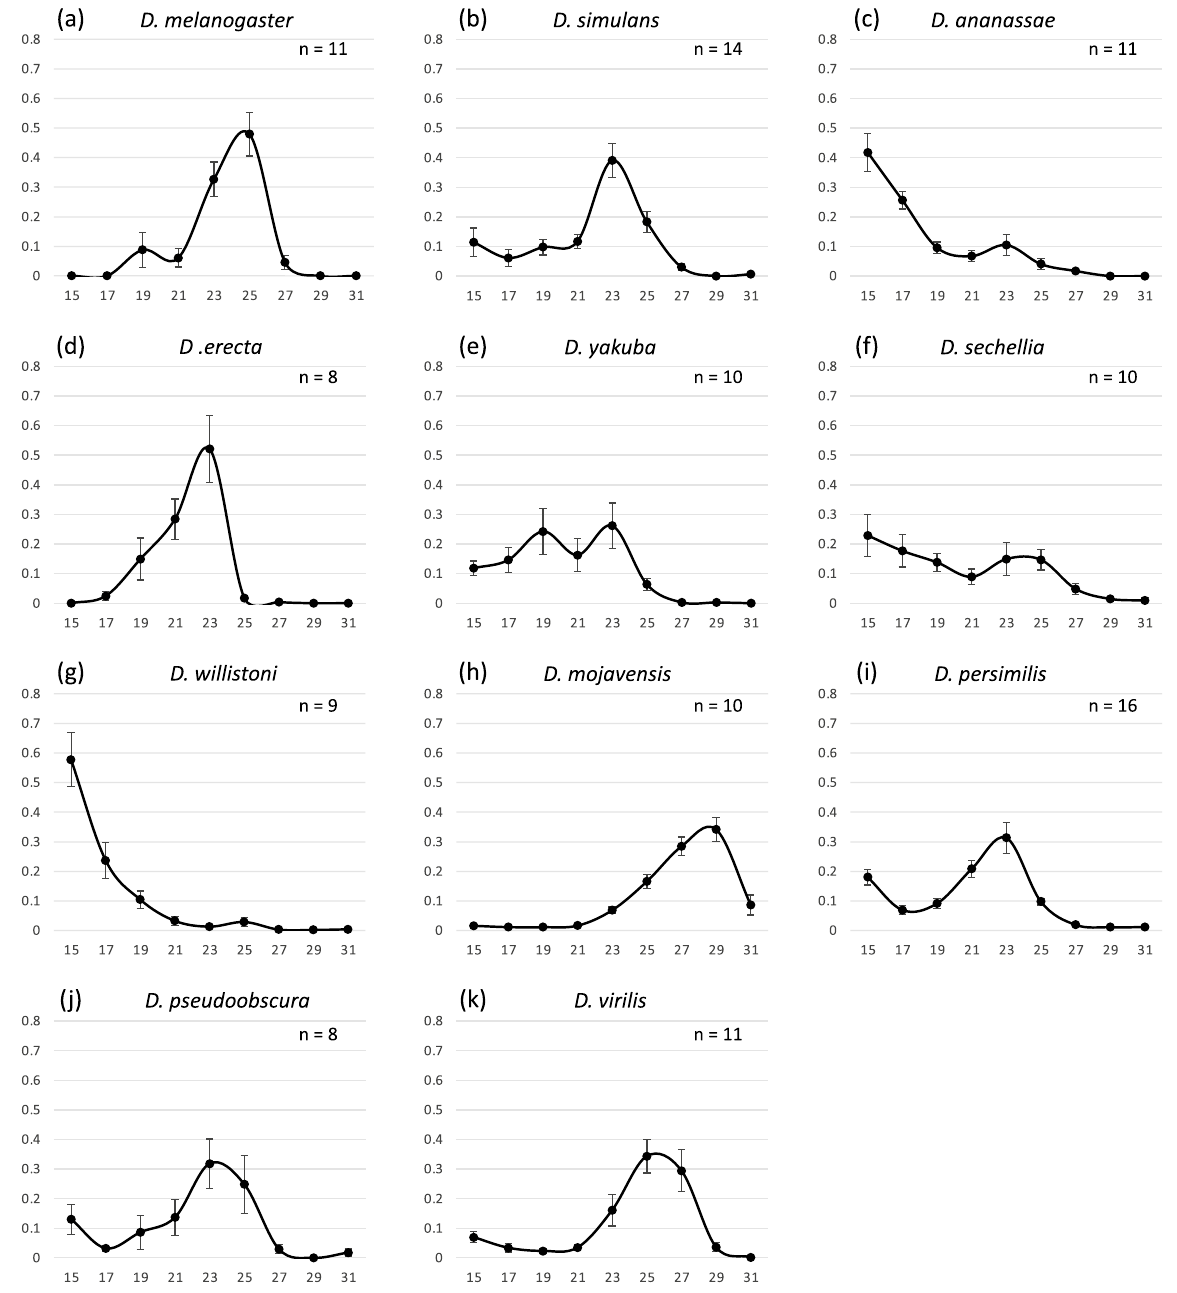
Figure 5. Temperature preference of 11 Drosophila species. ( a–k ) The distribution of flies on the temperature gradient field in each species; ( a ) D. melanogaster , ( b ) D. simulans , ( c ) D. ananassae , ( d ) D. erecta , ( e ) D. yakuba , ( f ) D. sechellia , ( g ) D. willistoni , ( h ) D. mojavensis , ( i ) D. persimilis , ( j ) D. pseudoobscura , and ( k ) D. virilis . Percentages (y axis) of the flies positioned in nine temperature ranges (x axis) are shown (see “Methods”). Error bars indicate standard error of